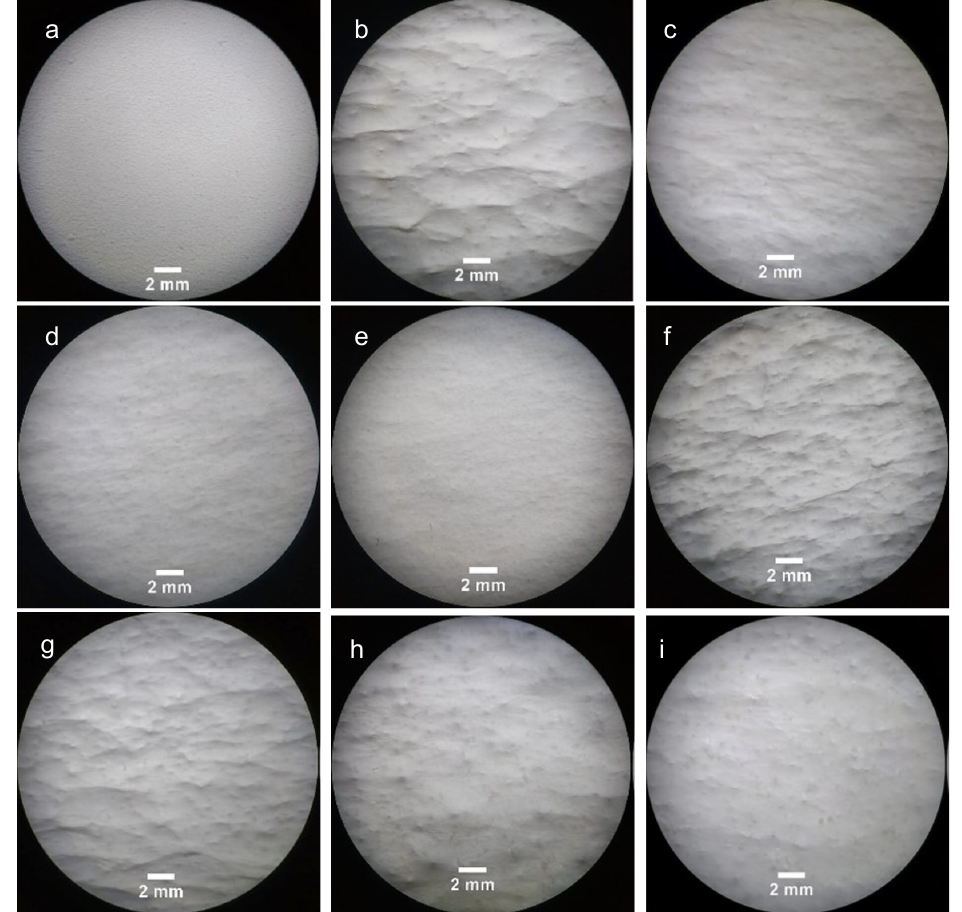
Figure 3. Macroscopic images of ( a ) electrospun PCL mats, PCL mats with CS flakes of different sizes: ( b ) 150–200 µm, ( c ) 100–150 µm, ( d ) 50–100 µm and ( e ) <50 µm; and PCL mats with CS flakes in the range of 50–200 µm at different mass ratios: ( f ) 1:0.5, ( g ) 1:1, ( h ) 1:2 and ( i ) 1:3.